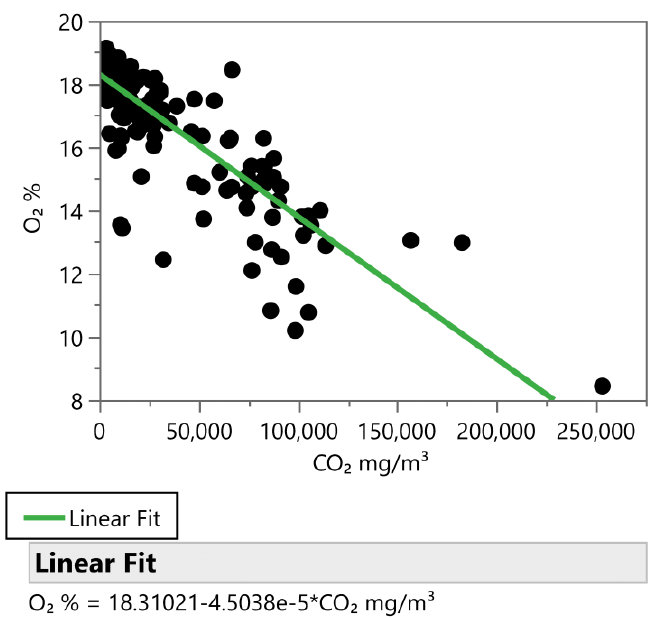
Figure 3. Regression analysis of the strongest dependencies of the studied parameters O 2 and CO 2. Table 4. Summary of fit—analysis of parameters O 2 and CO 2 dependencies.